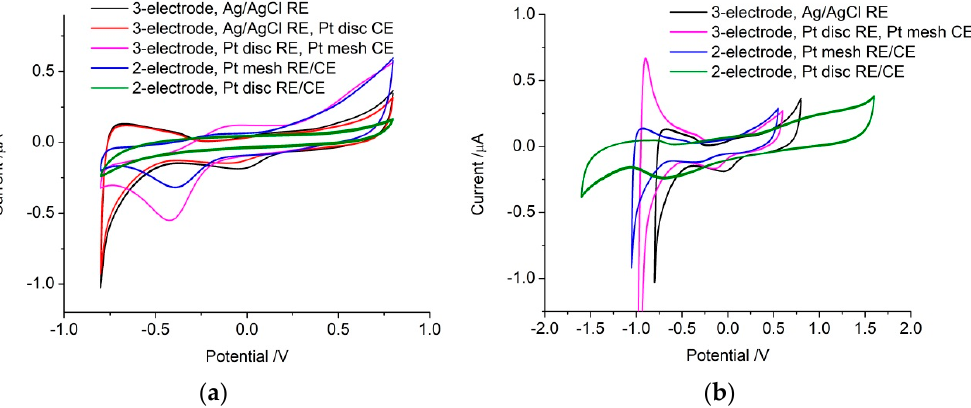
Figure 2. ( a ) Second voltammetric cycle of a platinum electrode in degassed 0.1 M NaCl from 0.8 to − 0.8 V at a scan rate of 100 mV s − 1 in a three- or two-electrode configuration. ( b ) Varying potential range to determine water window.